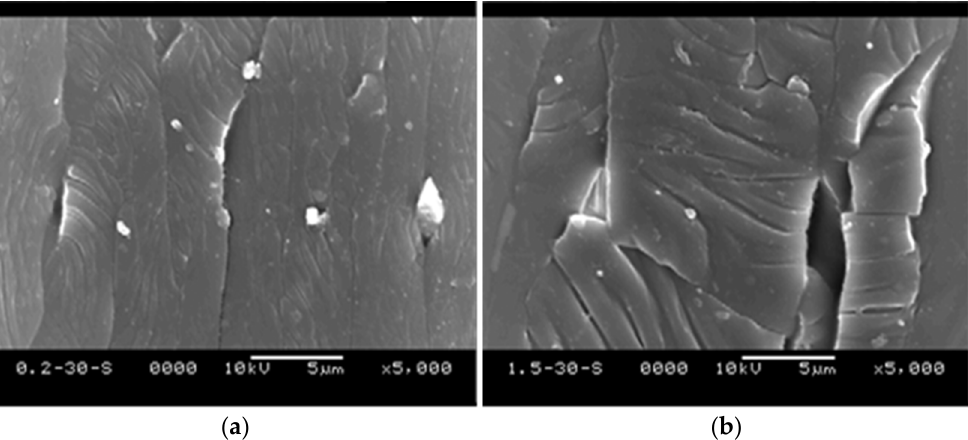
Figure 12. Surface photomicrographs of 15 s ( a ) and 30 s ( b ) UV-exposed polymer samples at 1.5 phr of photoinitiator concentration.